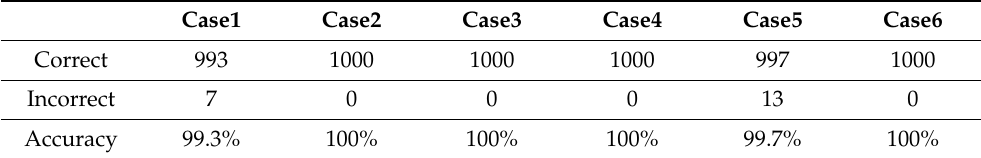
Table 5. The results of CNN for labeled data. Case1 Case2 Case3 Case4 Case5